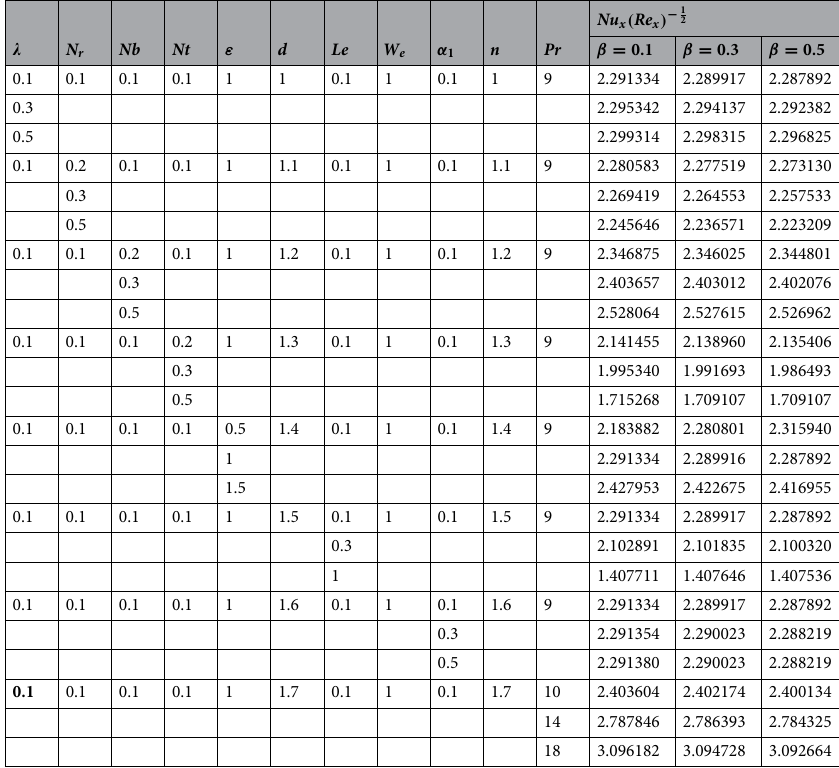
1 2 for distinct amounts of